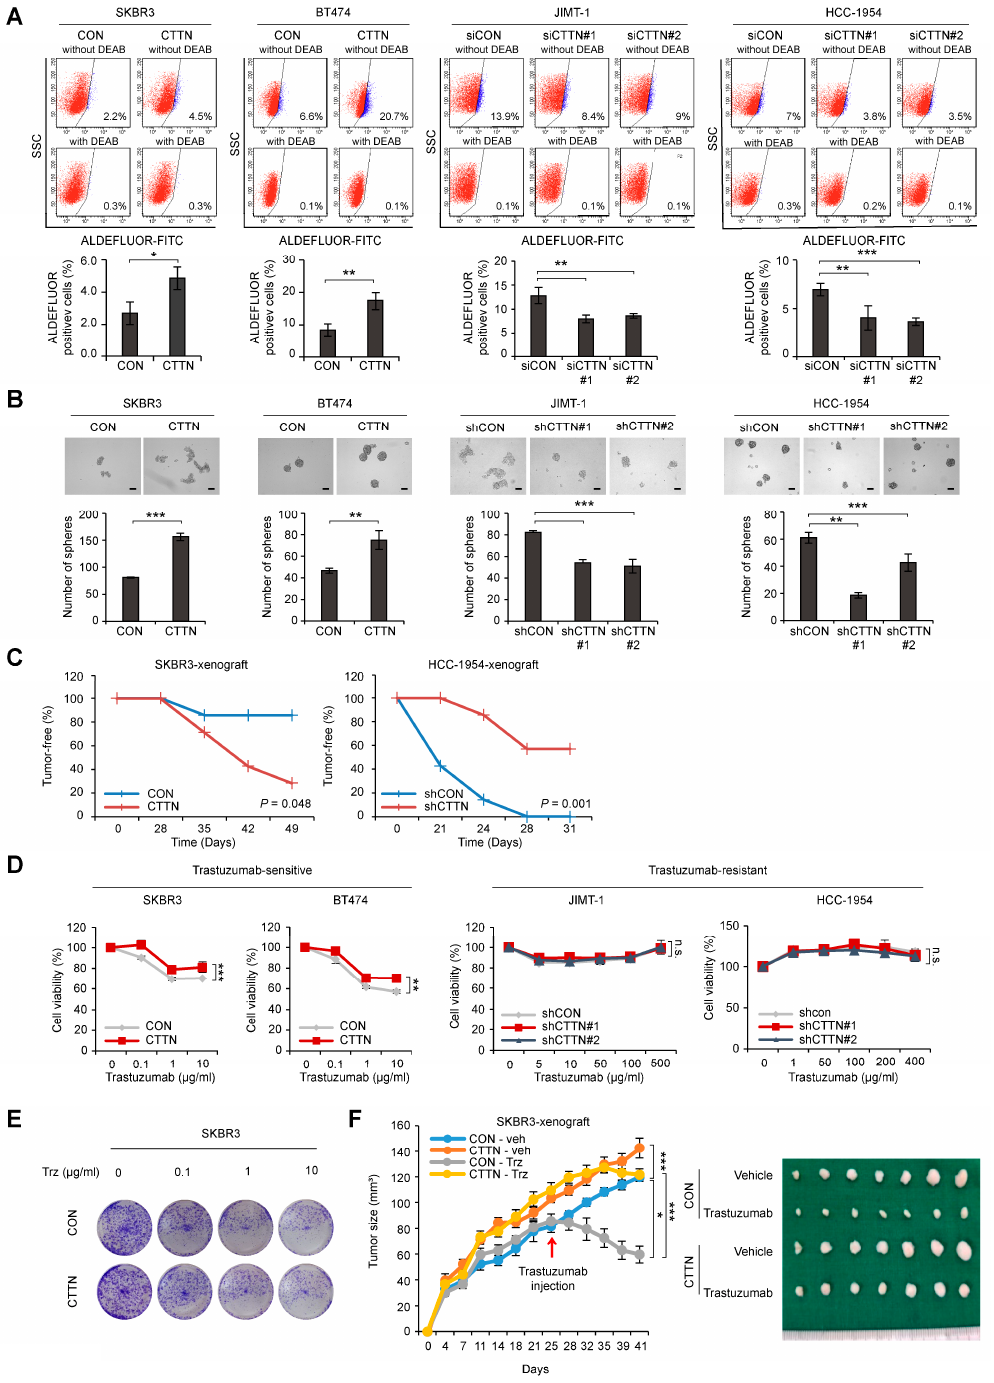
the survival of HER2+ breast cancer patients was analyzed based on CTTN expression in METABRIC ( top ) and KM plotter ( bottom ). ( F ) Analysis of the OS of HER2+ breast cancer patients in the Hanyang cohort (HYU, Hanyang University) according to CTTN expression. Groups were stratified by IHC- based CTTN protein expression. p -values were determined by the Kaplan–Meier method with the log-rank test. Representative photomicrographs of intensity scores for CTTN staining in HER2 positive breast cancer (right). (( i ): weak, ( ii ): strong, original magnification × 400, scale bars, 50 µ m).